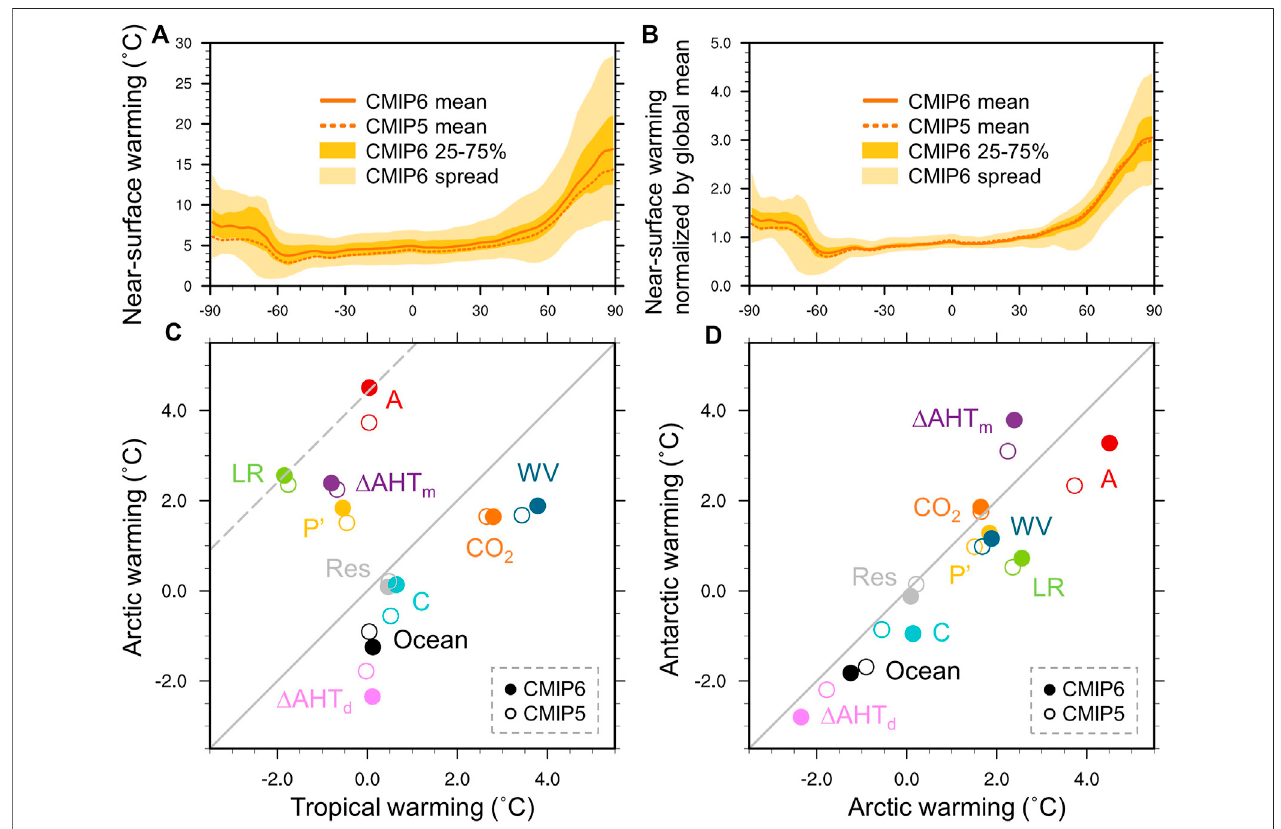
FIGURE 4 | (A) Annual- and zonal-mean near-surface warming ( ˚ C) averaged over 31 years centered on year-100 after CO 2 quadrupling for the CMIP6 (solid orangeline)andCMIP5(dashedorangeline)multimodelmeans.Thedarkorangeshadingshowsthe25thto75thpercentiles,andthelightorangeshadingshowsthefull intermodel spread for CMIP6. (B) As in (A) , but with zonal-mean near-surface warming normalized by global-mean near-surface warming within each model. (C,D) Contributions of each feedback and atmospheric forcing to warming ( ˚ C) centered around year-100 of abrupt CO 2 quadrupling in CMIP6 ( fi lled circles) and CMIP5 (hollow circles) for (C) thetropicsrelative totheArcticand (D) theArctic relativetotheAntarctic.Warmingcontributionsareshown forthelapse-rate(LR),surfacealbedo (A),water-vapor(WV),and cloud(C)feedbacks, thevariationinthePlanckresponsefromitsglobal-meanvalue(P ’ ),effectiveradiativeforcing(CO 2 ),changeinmoistand dryAHTconvergence( Δ AHT m ; Δ AHT d )andoceanheatuptake(Ocean),andresidualterm(Res).Dashedgreylineshowsa1-to-1slopethroughthelapse-ratefeedback warming